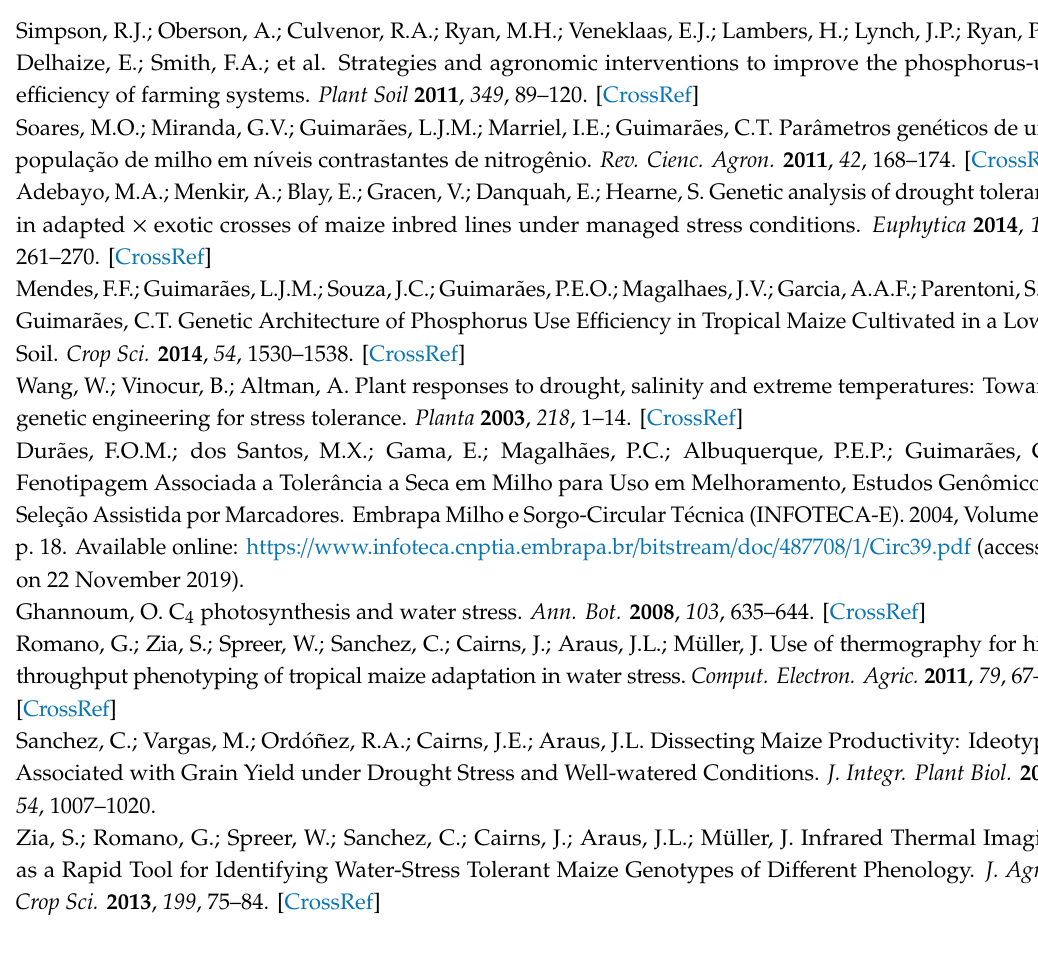
Figure S1: Mean weekly values, in days after sowing, of the temperature ( ◦ C), relative humidity (%) and solar radiation (MJ m − 2 day − 1 ) throughout the growth period of the popcorn lines (April to August 2016). Male flowering began 67 days after sowing (June 24). Table S1: Precipitation and irrigation (mm) applied, in days after sowing (DAS), to early and late popcorn genotypes under full irrigation (FI) and drought stress (DS). Table S2: Path analysis of the partitioning of genotypic correlations in components of direct and indirect e ff ects obtained from first-order agricultural traits and morphoagricultural, physiological, and second-order root traits evaluated in popcorn lines under FI and DS. Table S3: Path analysis of the partitioning of genotypic correlations in components of direct and indirect e ff ects obtained between the main trait and first-order agricultural traits and morphoagricultural, physiological, and second-order root traits evaluated in popcorn lines under FI and